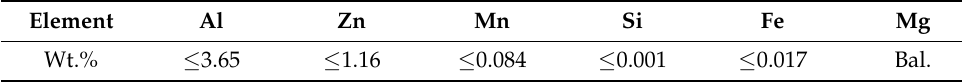
Table 1. Composition of AZ31B Magnesium Alloy [27].